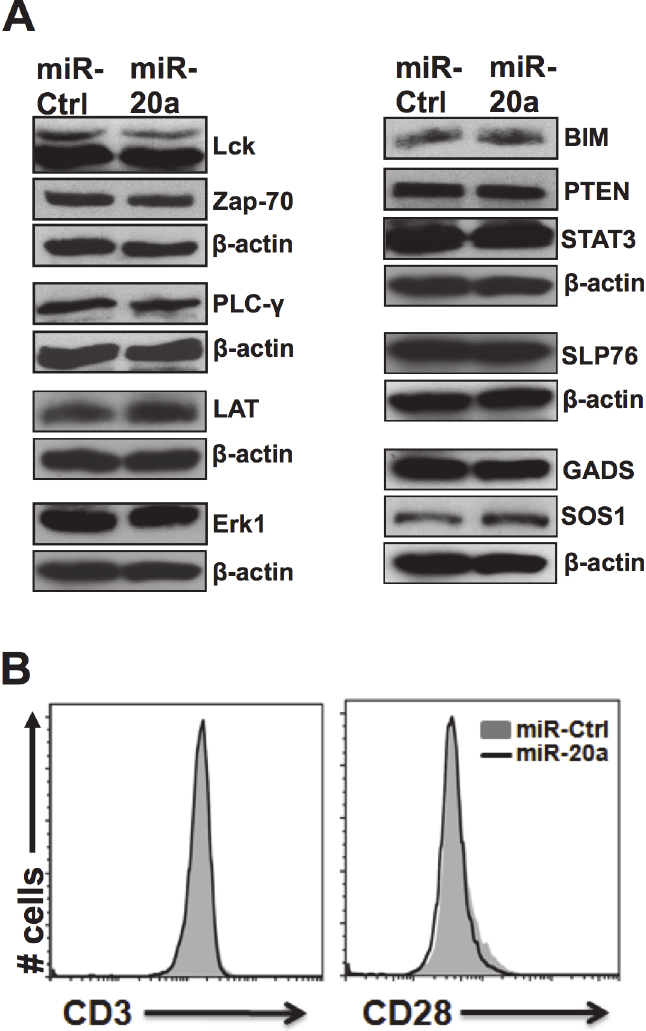
Fig 3. miR-20a does not affect the expression of signaling molecules and CD3 and CD28 receptors. (A) Lysates from T cells transfected with either miR-20a or miR-control were prepared and analyzed by immunoblotting using the indicated Abs. (B) CD4 + T cells overexpressing either miR-20a or miR-control cells were stained with antibodies against CD3 and CD28 and analyzed by flow cytometry. Histograms overlay show the expression of CD3 (left) and CD28 (right) in miR-20a versus miR-control transfected cells.